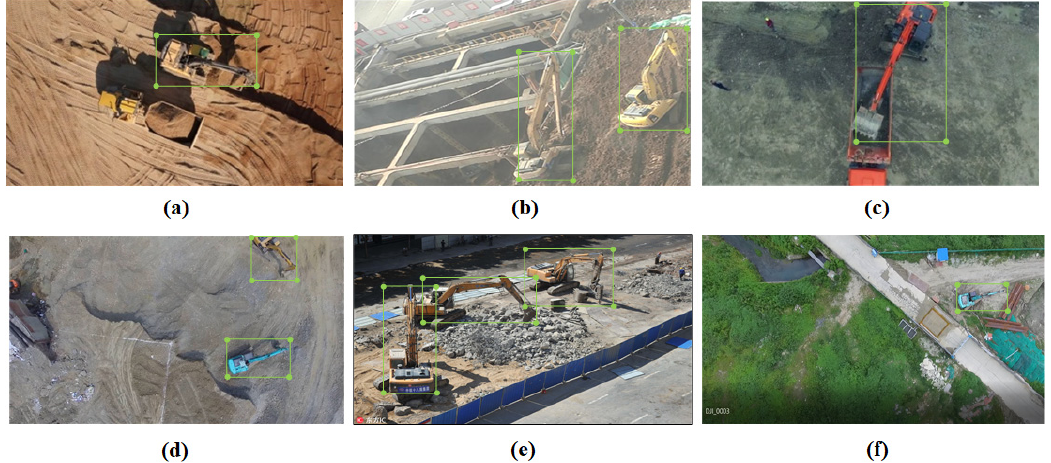
Figure 1. Examples of the annotated images containing excavators of different sizes, colors, and postures. The images were taken from different viewing directions. ( a ) Vertically viewed image with a yellow excavator; ( b ) obliquely viewed image with two yellow excavators; ( c ) obliquely viewed image with a red excavator; ( d ) vertically viewed image with two excavators of different colors; ( e ) obliquely viewed image with three yellow excavators in different postures; and ( f ) vertically viewed image with a blue excavator.